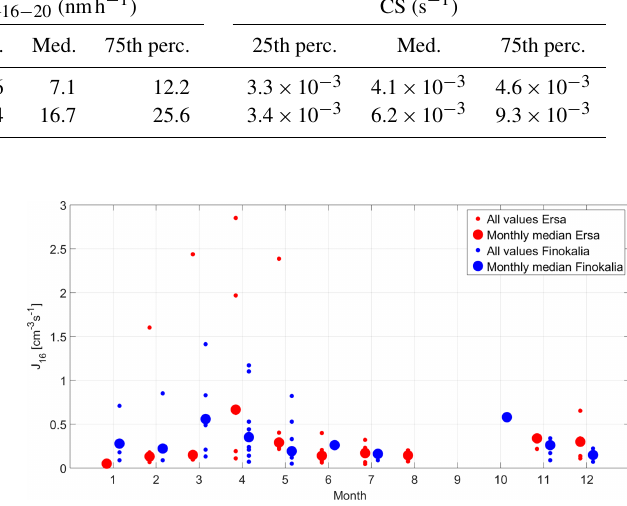
Figure 5. Annual variation of the 16nm particle formation at Ersa and Finokalia for type I events. Small dots represent all values, while large dots stand for median